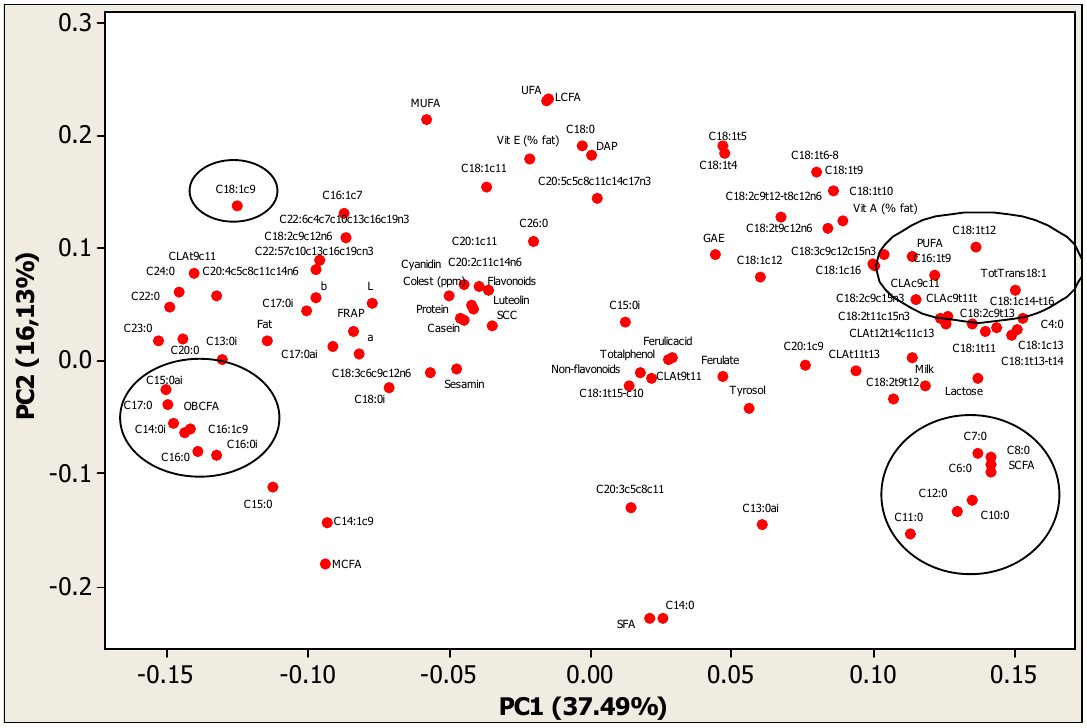
Figure 1. Plot of the loadings of the first two principal components (PC1 and PC2; variance explained 37.49 and 16.13, respectively).